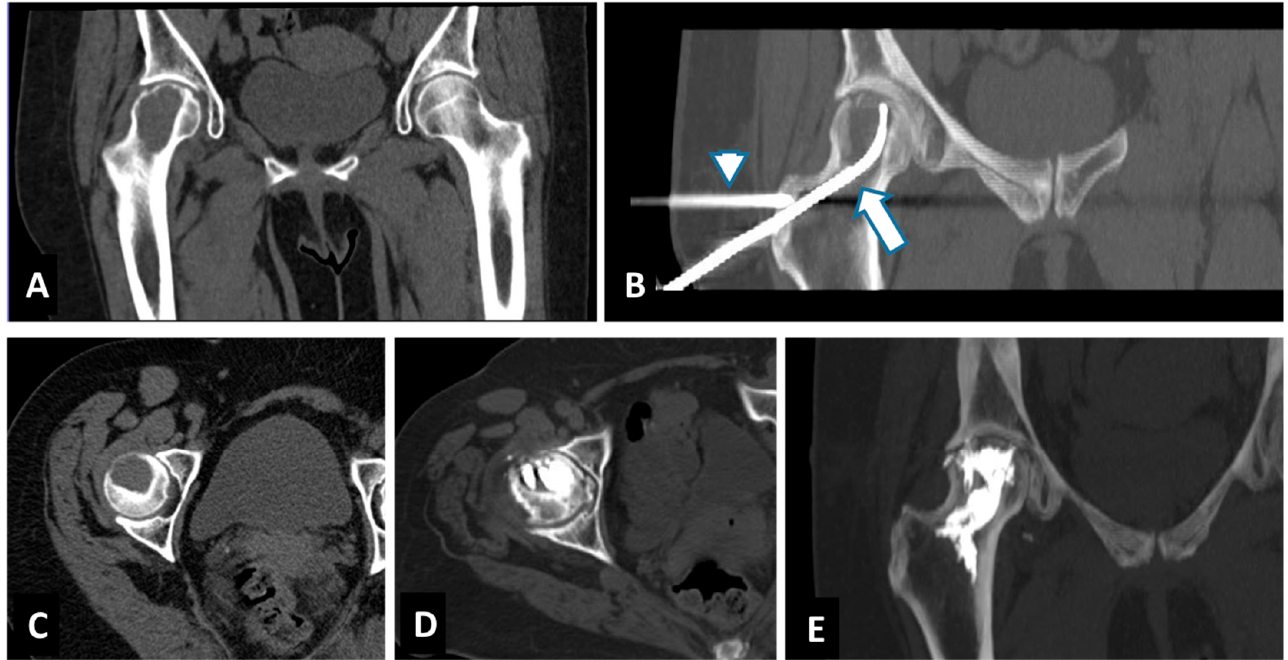
Figure 1. Median VAS score follow-up evaluated before and prospectively after 1 week, and 1, 3, 6 and 12 months from the treatment. The red line indicates patients’ changes in pain.